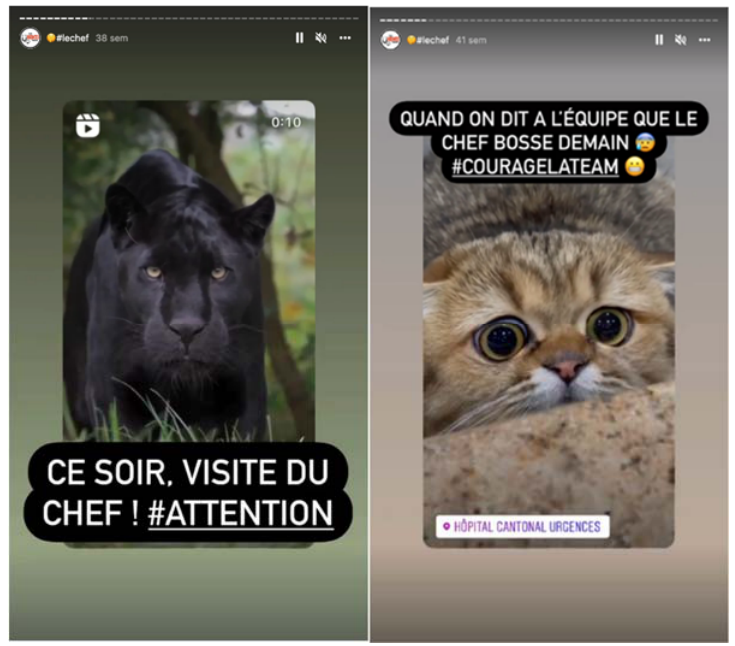
Figure 9. The “e ‐ boss”: a humorous imaginary character, mysterious, sometimes tyrannical, but who pushes his teams towards the best ( Left screenshot): “When the team knows the boss is working tomorrow #couragetheteam”; ( Right screenshot): “Tonight, visit of the Chief! #watch out”.